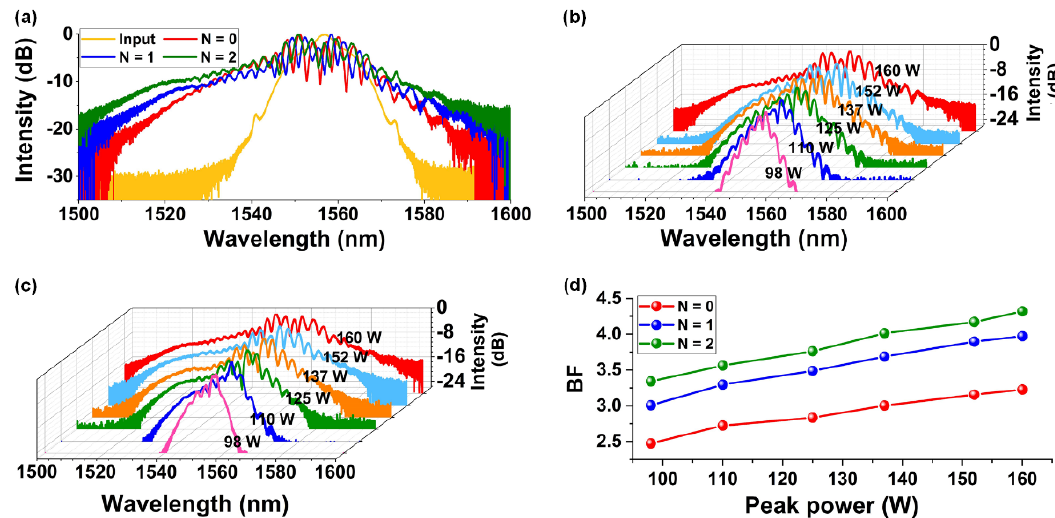
Figure 4. SPM experimental results. ( a ) Normalized spectra of optical pulses before and after propagation through the GO-coated SOI nanowires with one and two layers of GO at an input peak power of ∼ 160 W. ( b , c ) Optical spectra measured at different input peak powers for the hybrid waveguides with one and two layers of GO, respectively. ( d ) BFs of the measured output spectra versus input peak power for the hybrid waveguides with one and two layers of GO. In ( a – d ), the corresponding results for the uncoated SOI nanowires ( N = 0) are also shown for comparison.